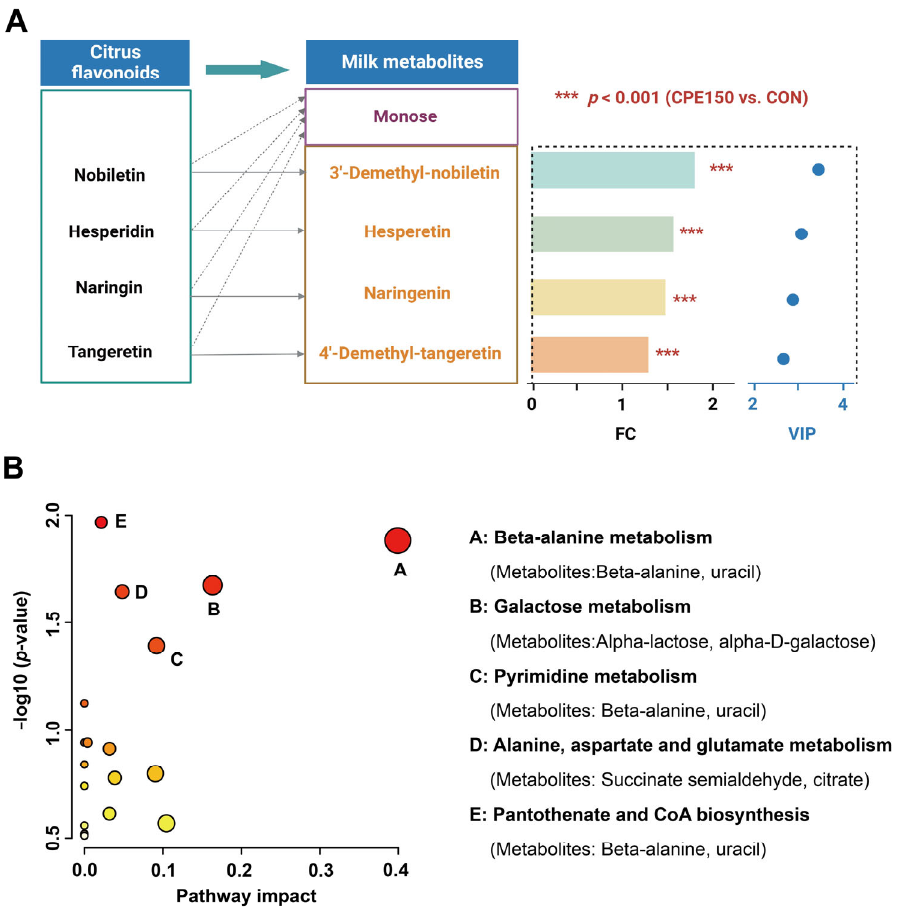
Figure 6. Key differentially expressed metabolites analysis. ( A ) The aglycones of flavonoids were enriched in the milk of dairy cows fed the supplementary citrus peel extracts at 150 g/d (CPE150) in comparison with the control diet (CON); Blue points indicate VIP values of metabolites ( B ) Overview of pathway analysis based on the differentially expressed metabolites between the milk of dairy cows fed the CON vs. CPE150. FC, fold change; VIP, variable importance in the projection.